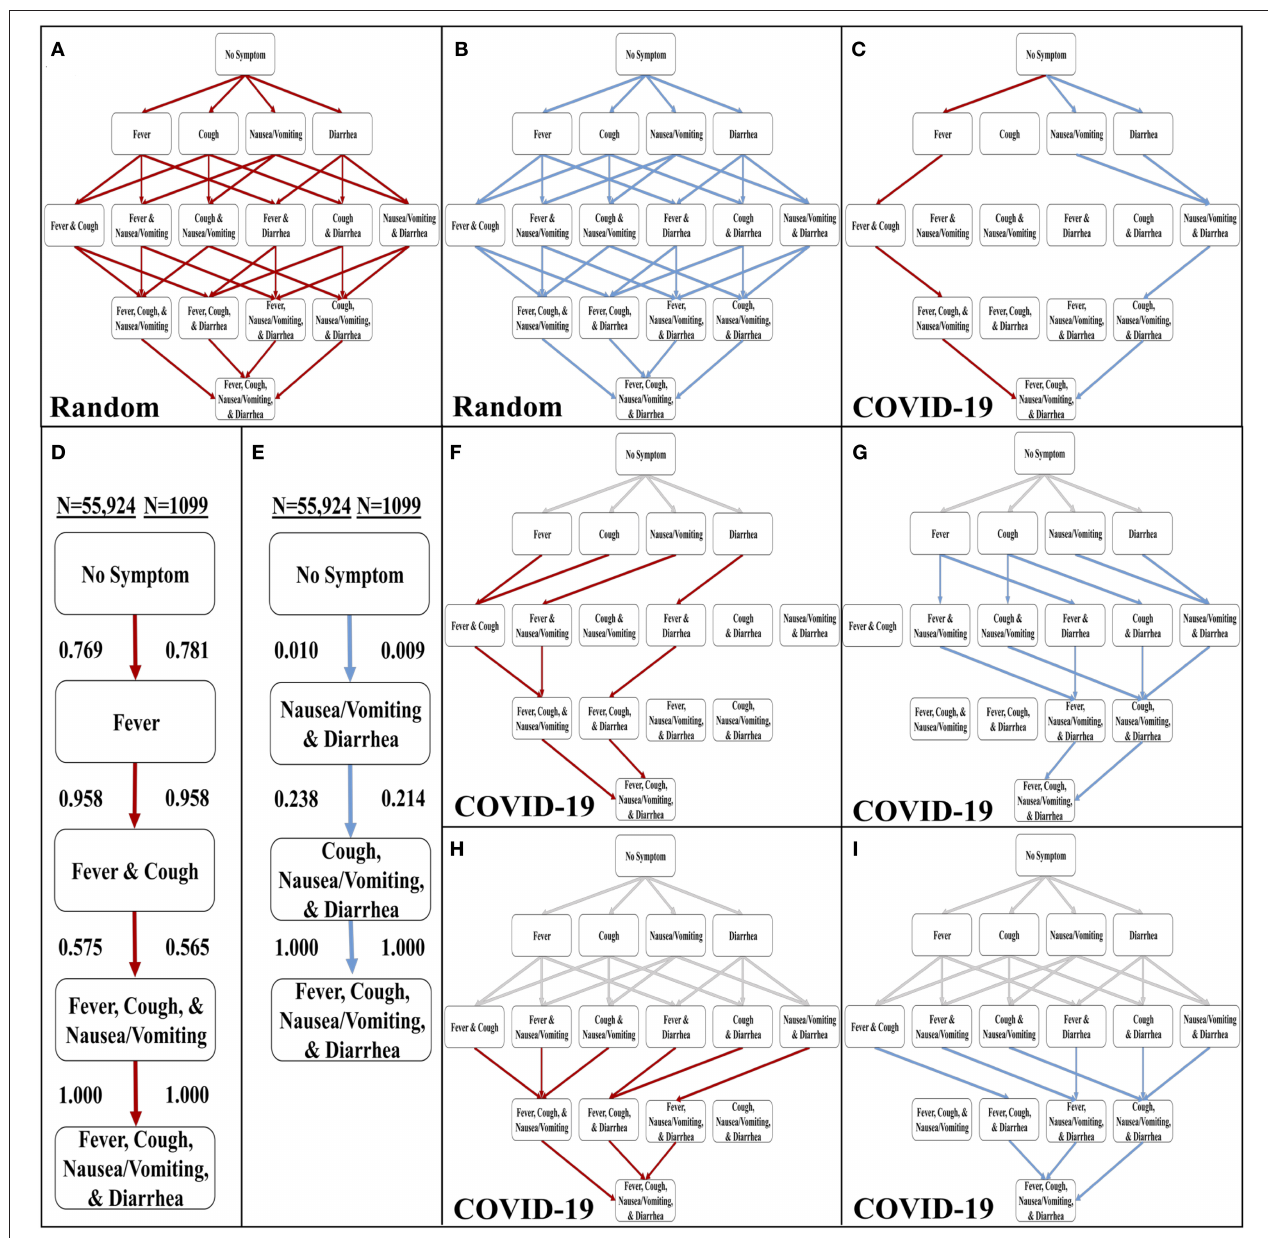
FIGURE 1 | Development of the stochastic progression model for COVID-19. (A) The most likely paths (red) in the Hasse Diagram for symptoms with random likelihoods of occurring. (B) The least likely paths (blue) in the Hasse Diagram for symptoms with random likelihoods of occurring. (C) The most likely (red) and least likely (blue) paths in the Hasse Diagram for symptoms in COVID-19. (D) The most likely order of symptoms in COVID-19 based on our Stochastic Progression Model determined from transition probabilities presented here. (E) The least likely order of symptoms in COVID-19 based on our Stochastic Progression Model determined from transition probabilities presented here. (F) Hasse Diagram of the most likely paths (red) after traveling any forced path (gray) of patients with one symptom. (G) Hasse Diagram of the least likely paths (blue) after traveling any forced path (gray) of patients with one symptom. (H) Hasse Diagram of the most likely paths (red) after traveling any forced path (gray) of patients with two symptoms. (I) Hasse Diagram of the least likely paths (blue) after traveling any forced path (gray) of patients with two